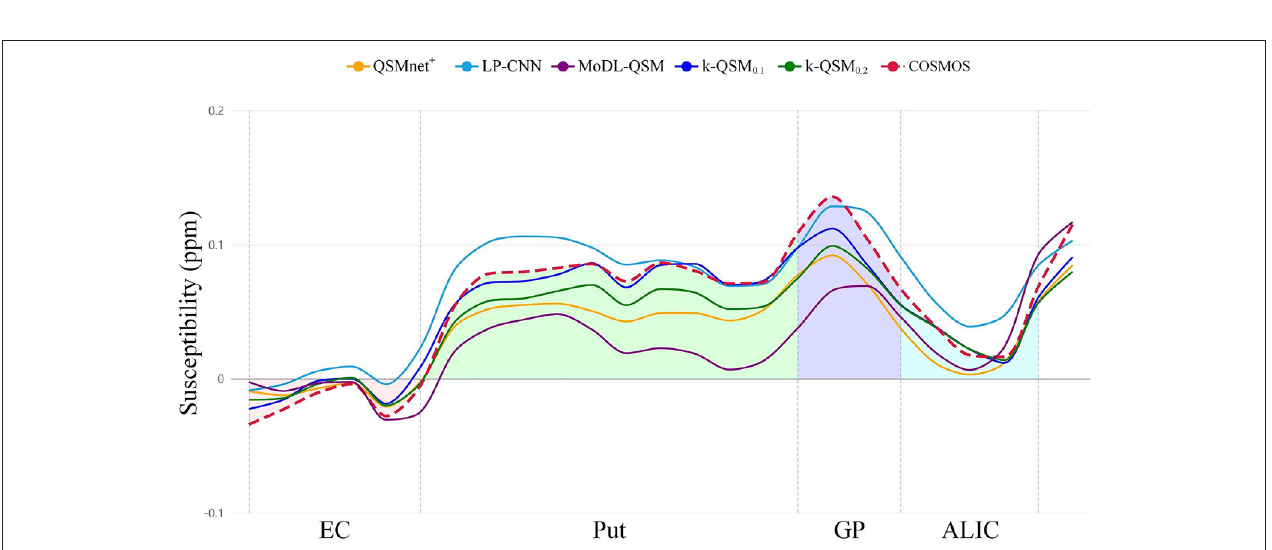
FIGURE 7 | The profiles of susceptibility values calculated along the lines outlined in Figure 5 crossing external capsule (EC), putamen (Put), globus pallidus (GP), and anterior limb of internal capsule (ALIC) are plotted in the chart with color regions enclosed by calculation of susceptibility through multiple orientation sampling (COSMOS) and the